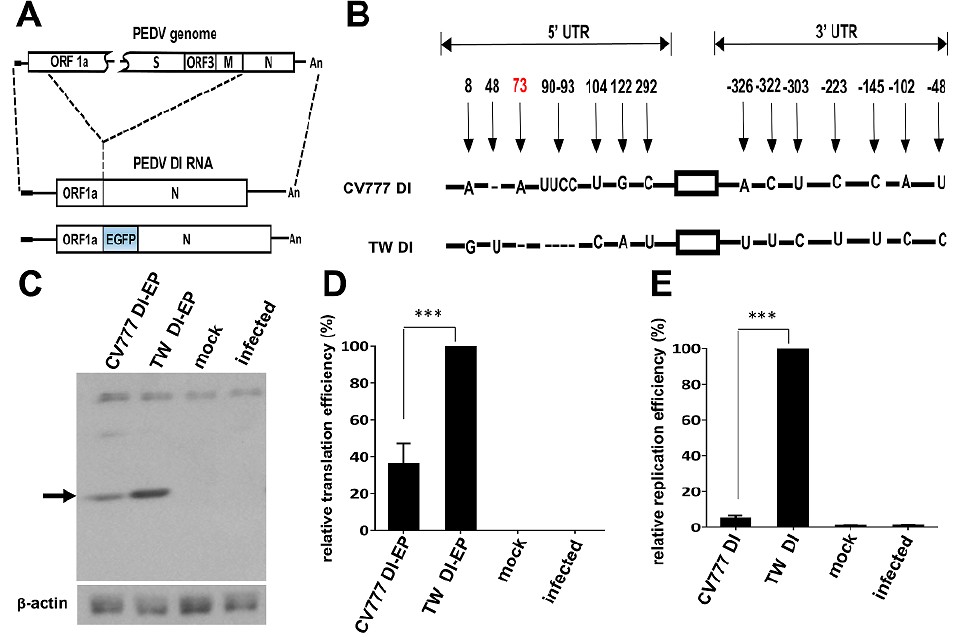
Figure 4. Effects of variations in the 5 ′ and 3 ′ UTRs between CV777 and TW strains on translation and replication. ( A ) Diagram showing the genome structure of the PEDV TW strain, PEDV defective interfering (DI) RNA, and PEDV DI RNA with the EGFP gene. ( B ) Illustration of sequence variations in both the 5 ′ and 3 ′ UTRs between the PEDV Taiwan strain DI RNA (TW DI) and CV777 strain DI RNA (CV777 DI). ( C ) Detection of translation from TW DI-EP and CV777 DI-EP in Vero cells using western blotting with an antibody against EGFP. ( D ) Relative translation efficiency between TW DI-EP and CV777 DI-EP, as based on the results shown in (C). ( E ) Relative replication efficiency between TW DI and CV777 DI, as quantitated by RT-qPCR. The values in (D) and (E) represent the means ± standard deviation (SD) of three individual experiments. *** p < 0.001.